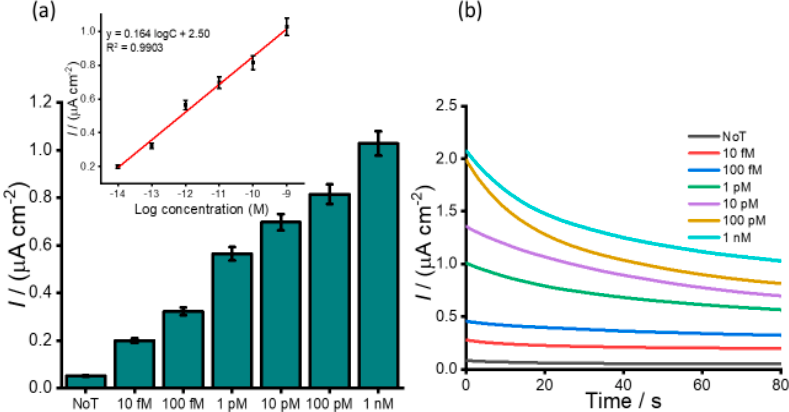
Figure 6. ( a ) Bar diagram corresponding current densities for the designated concentrations of spiked plasma. Inset, linear calibration plot showing concentration–current density relationship. ( b ) Amperometric responses corresponding to the designated starting concentration of HOTAIR sequences ranging from 10 fM to 1.0 nM in spiked plasma samples. Error bars represent the standard deviation of three repeated experiments.